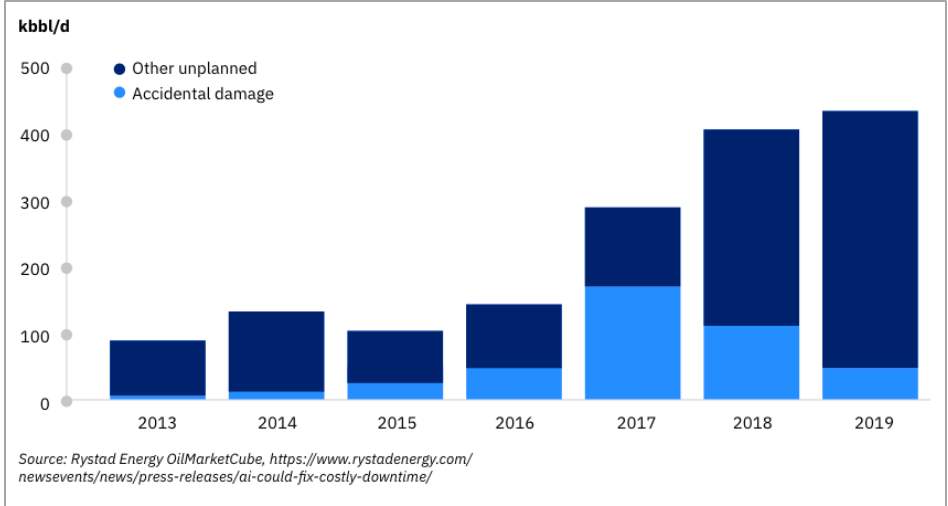
Figure 3. Global average of barrels of oil lost daily due to downtime [9]